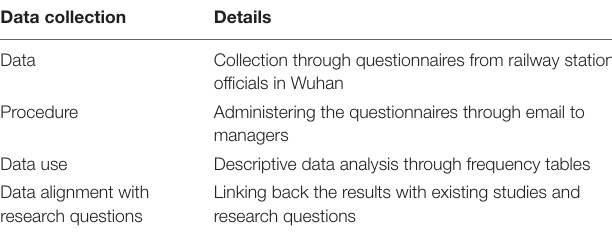
TABLE 1 | Summary of data collection procedure (Self-drawn).